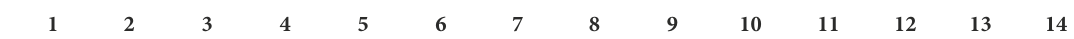
TABLE 1 Subscale correlations, reliabilities, means, and standard deviations ( N = 116).